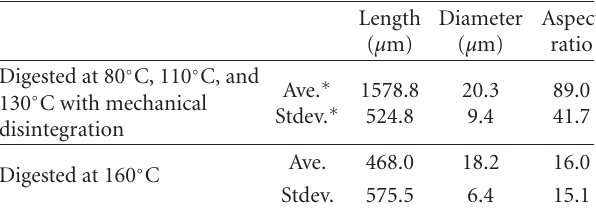
Table 2: Average and standard deviation of the fiber